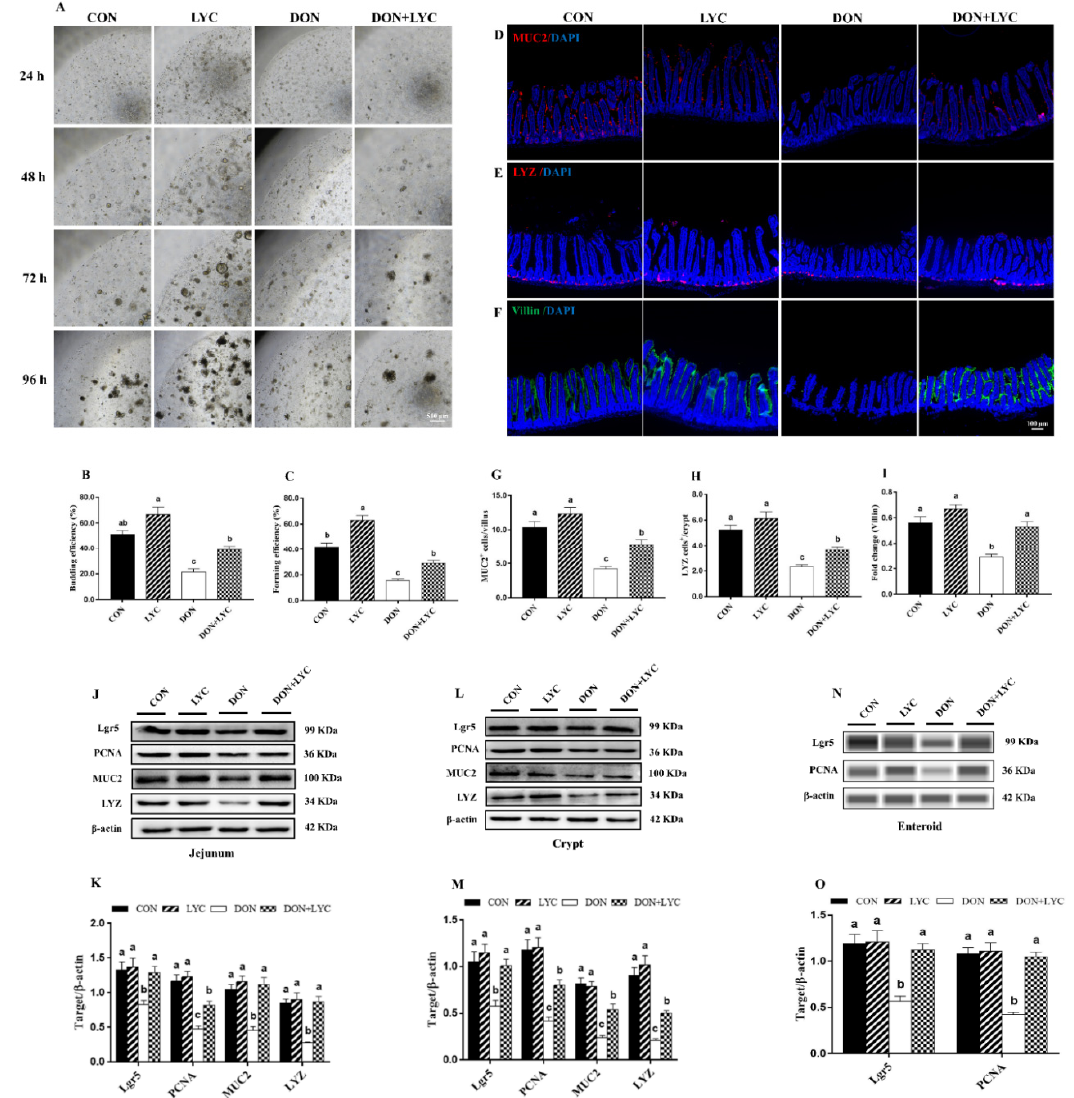
Figure 4. LYC treatment stabilized the functions of intestinal epithelial cells under DON exposure. ( A ) Represented images of enteroids expended from crypt stem cells. ( B , C ) Enteroid forming and budding efficiency. ( D – F ) Represented images of immunohistochemistry staining with MUC2, LYZ, and Villin antibodies in the jejunum. ( G , H ) Statistical analysis of MUC2+ cells and LYZ+ cells. ( I ) Statistical analysis of fluorescence intensity of Villin. ( J , K ) Protein expression of PCNA, Lgr5, MUC2, and LYZ in the jejunum. ( L , M ) Protein expression of PCNA, Lgr5, MUC2, and LYZ in the crypt. ( N , O ) Protein expression of Lgr5 and PCNA in the enteroids of mice. Results are presented as mean ± SEM ( n = 3). Columns with different superscripts letters indicating significant difference ( p < 0.05).